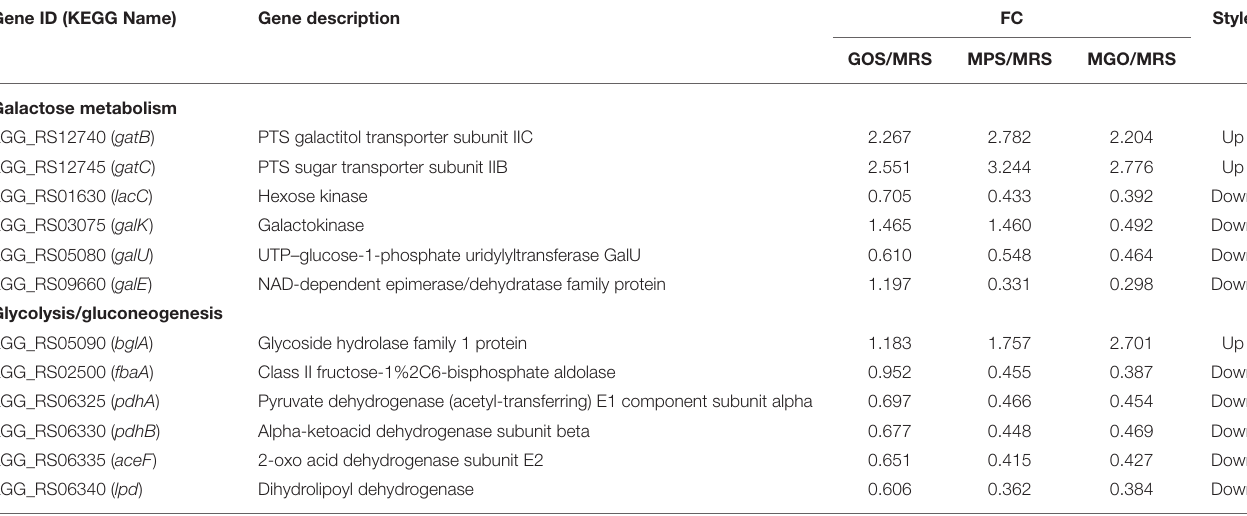
TABLE 3 | Effect of different prebiotics on galactose metabolism- and glycolysis/gluconeogenesis- related gene transcription in LGG cultured for